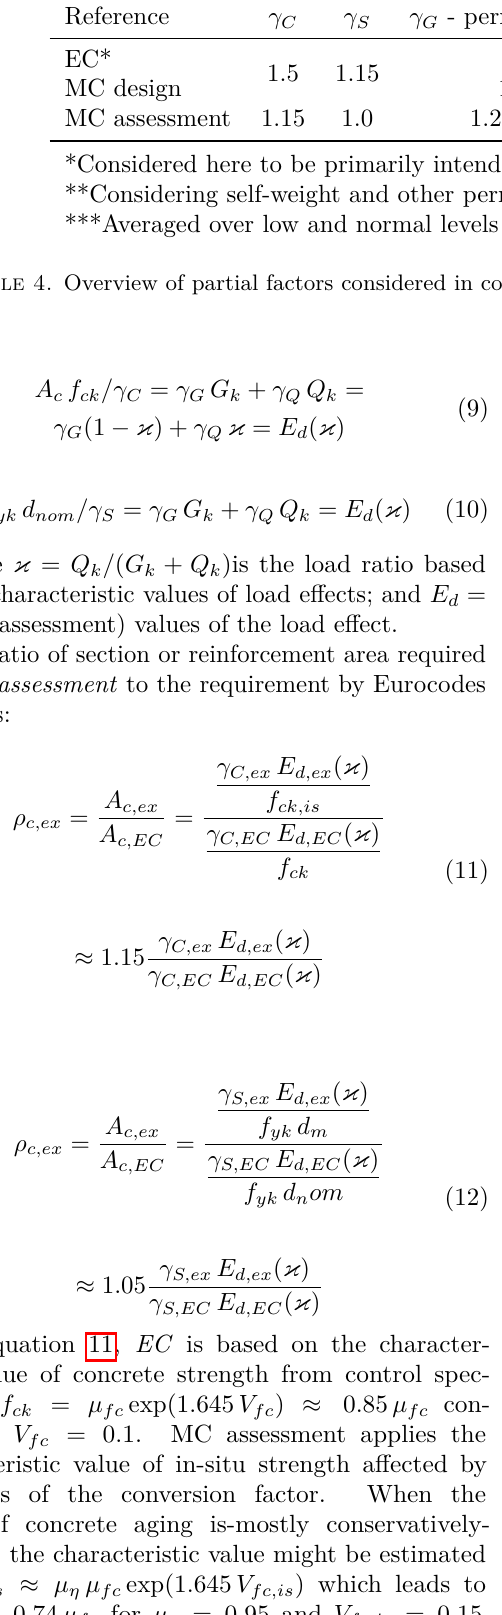
Figure 3. Variation of ratio ρ for MC